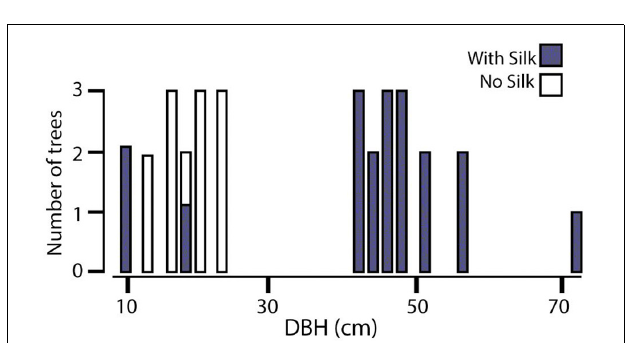
FIGURE 4 | Colony dispersion on trees of different sizes in an abandoned Tonkabean plantation in the Northern Range Mts of Trinidad. DBH, diameter at breast height.